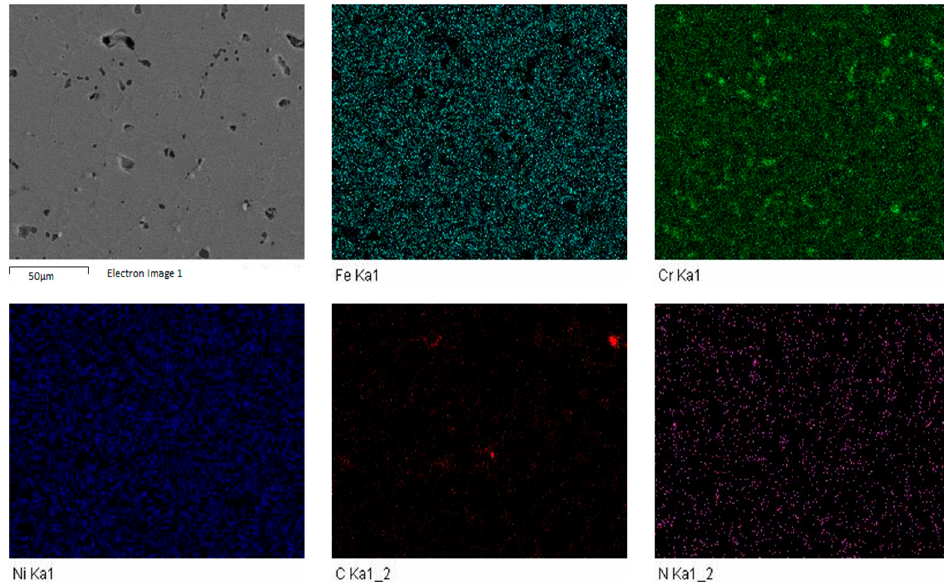
Figure 5. FESEM-EDS elemental mapping for sample S1.